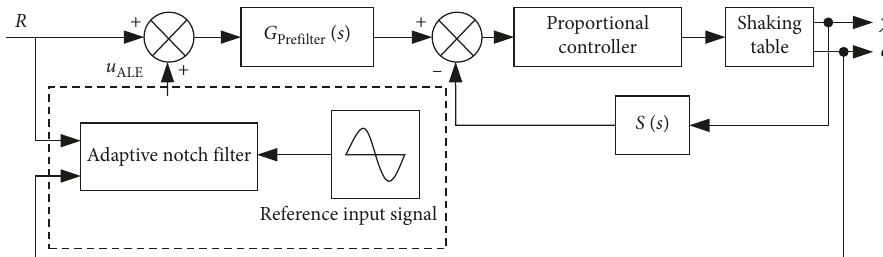
Figure 5: Principle of suppression of the resonance.